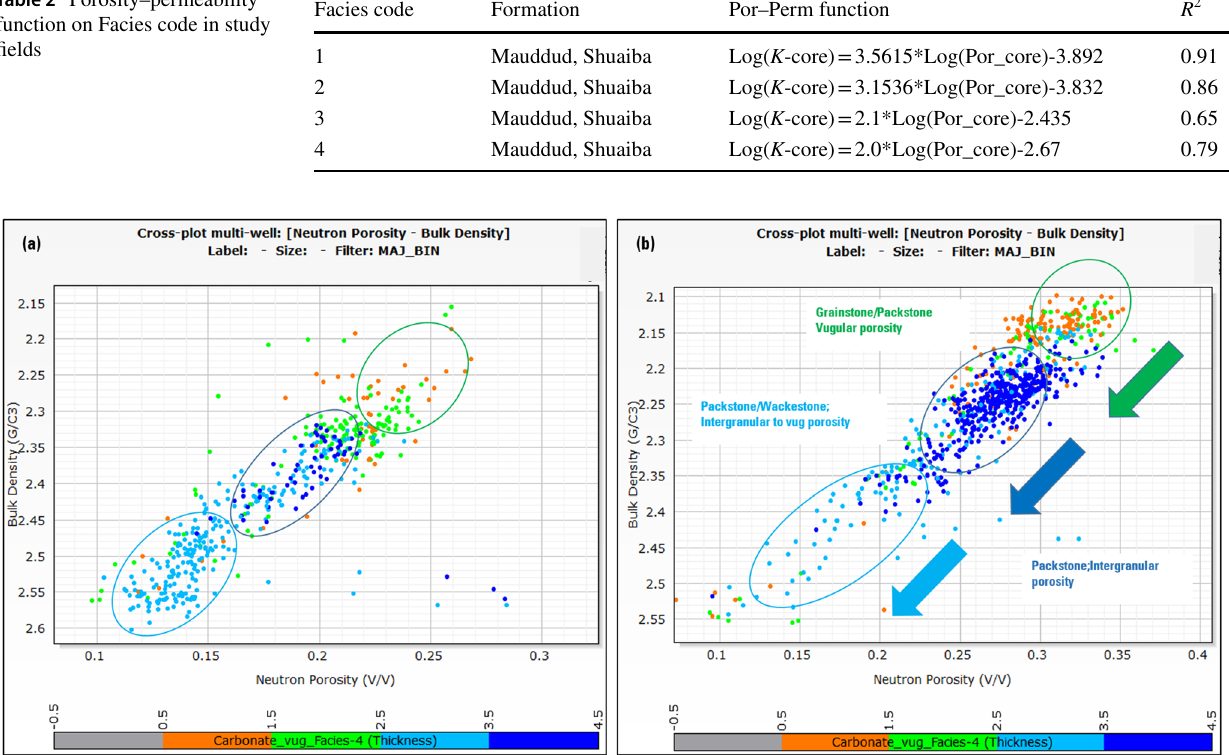
Fig. 7 Porosity Permeability transform in Mauddud and Shuaiba Formation. a all Facies Codes, b Facies Code 1, c Facies Code 2, d Facies Code 3 and e Facies Code 4 Table 2 Porosity–permeability